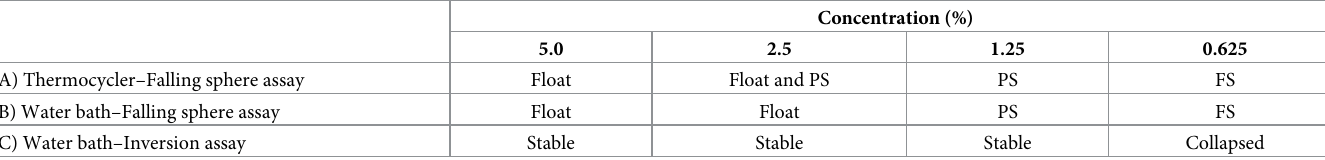
Table 1. Gelation results of gelatin.